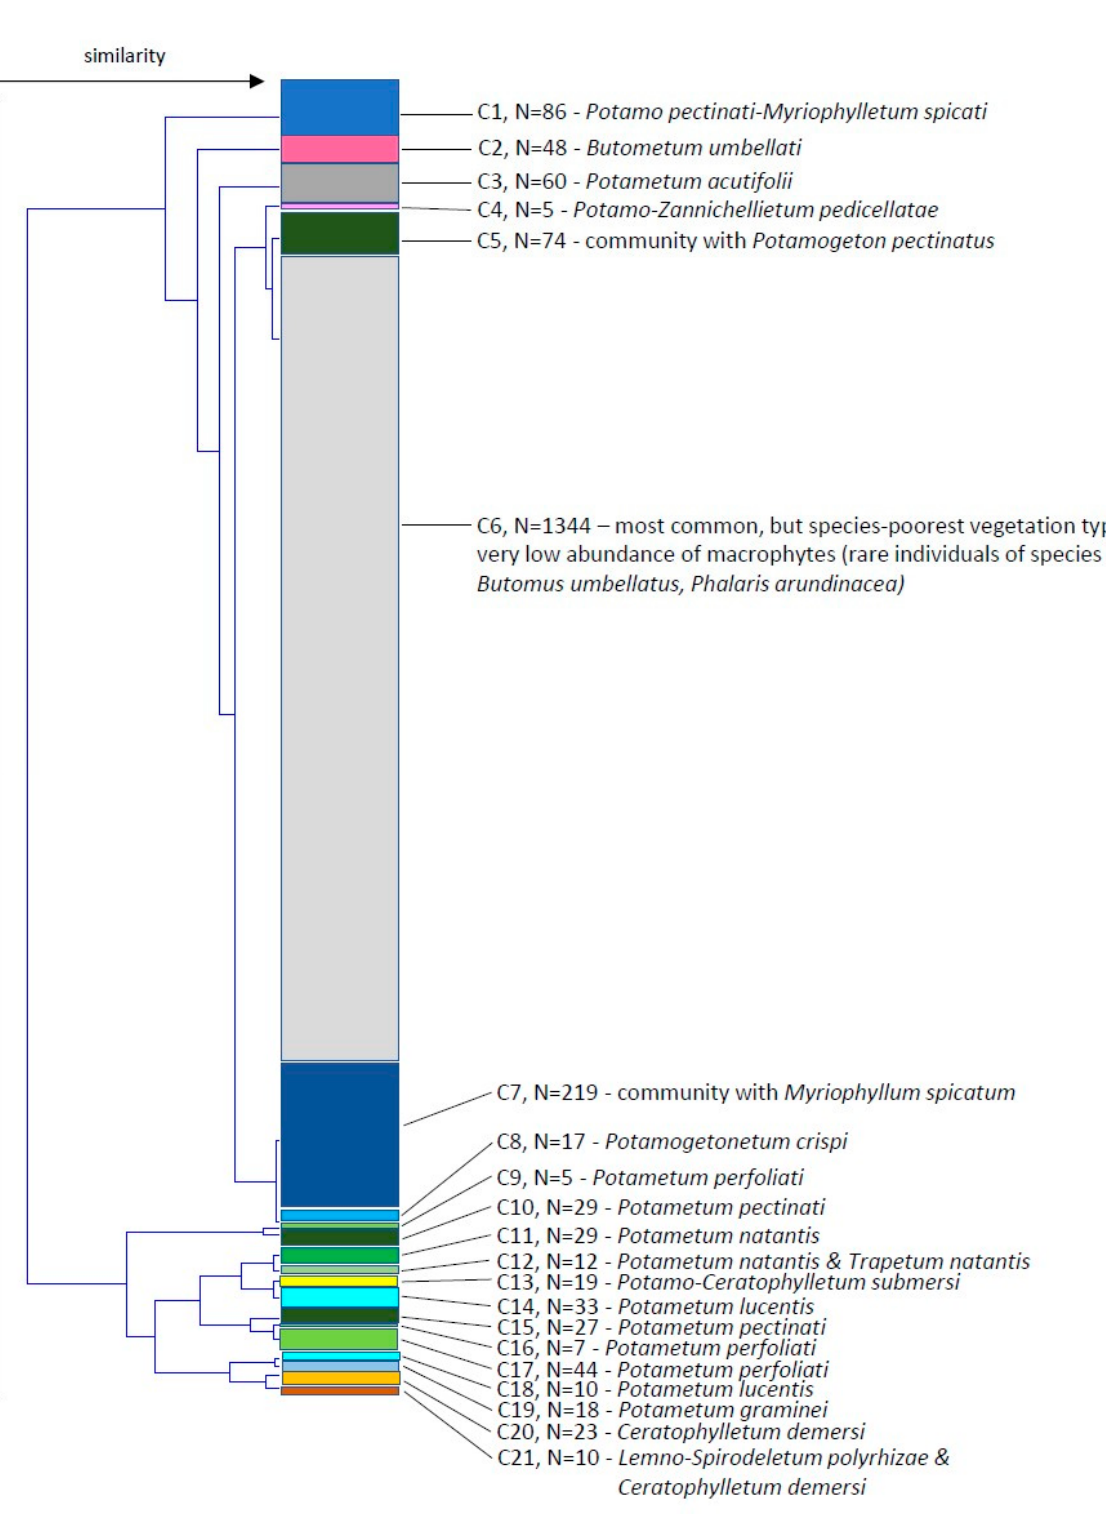
Figure 5. Similarity of the macrophyte communities comparing different stretches along the River Danube using Ward’s linkage method and Euclidean distance similarity index. C—cluster, N—number of stretches in the cluster.